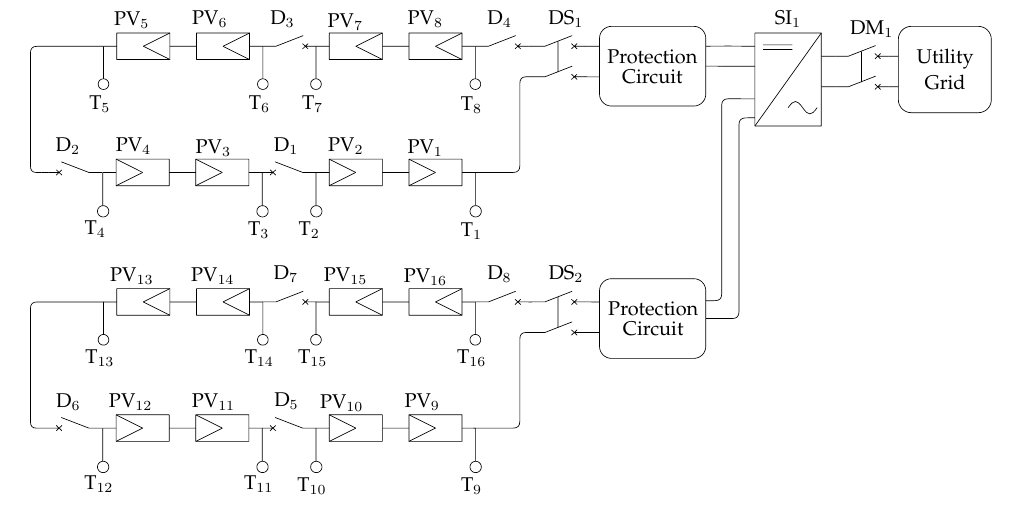
Figure 6: The proposed method consists in transmitting a frame using ⌈ α n cha ⌉ channel uses for the fi rst trans- Figure 6. Installed Photovoltaic Plant Electrical Diagram. mission attempt, with 0 < α ≤ 1 . In the event of a decoding error, incremental redundancy is transmitted